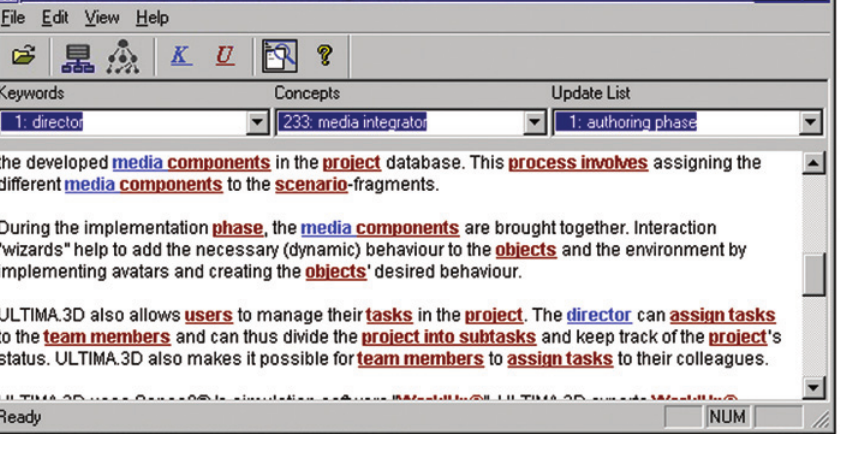
Figure 4. Some Examples of the